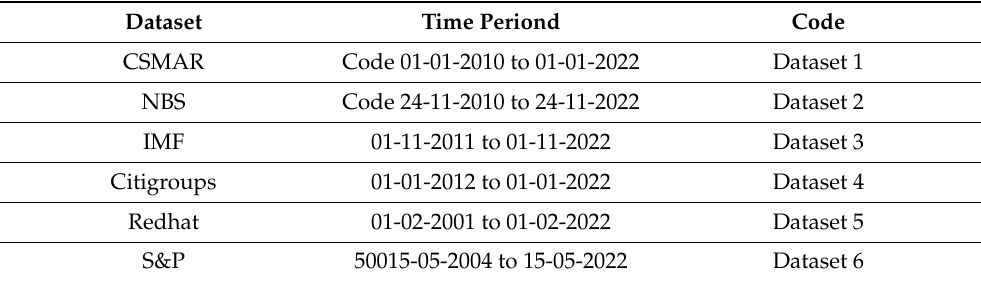
Table 1. The time period selected for each dataset.